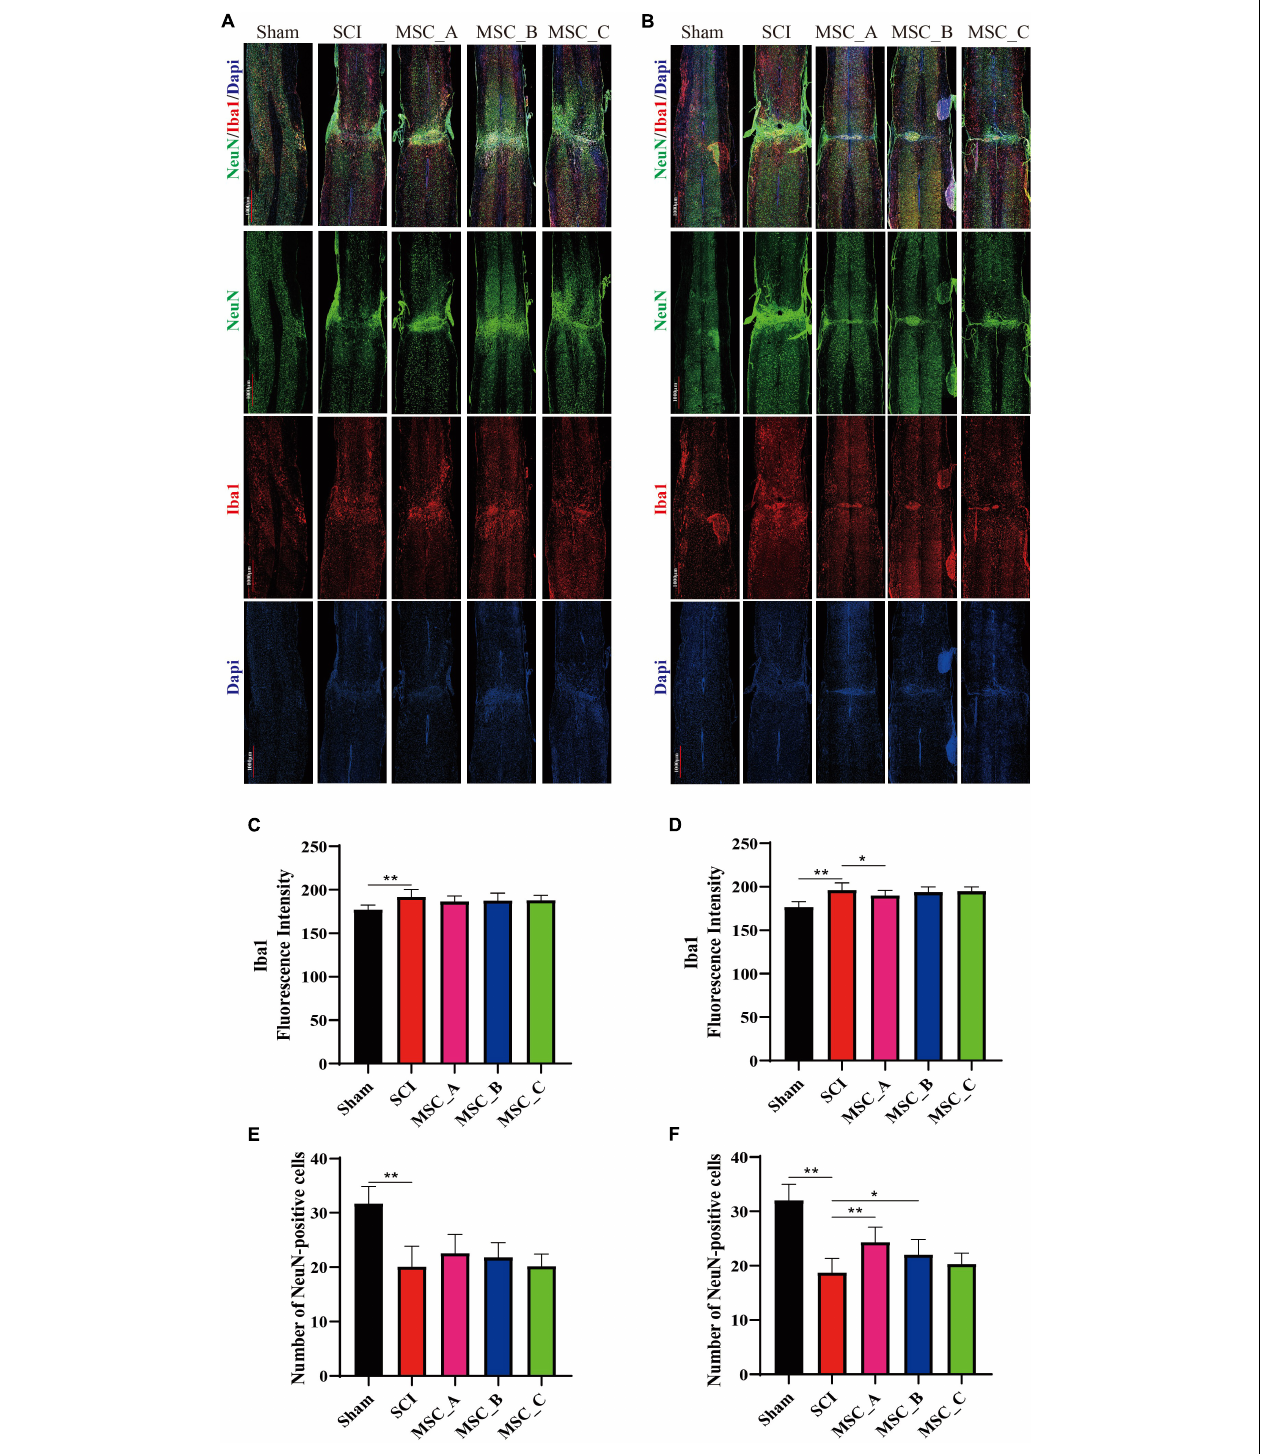
FIGURE 6 | Ionized calcium binding adaptor molecule 1and NeuN immunofluorescence staining at 1 week and 1 month after hUCMSC treatment at dpo 3. Confocal images of immunostaining confirmed the expressions of ionized calcium binding adapter molecule 1 (Iba1, in red), neuron (NeuN, in green), and nucleus (DAPI, in blue) at 1 week (A) and 1 month (B) after hUCMSC transplantation. Quantification of Iba1 fluorescence intensity at 1 week (C) and 1 month (D) after hUCMSC transplantation. Quantification of the NeuN-positive cell number at 1 week (E) and 1 month (F) after hUCMSC transplantation. All data are presented as the mean ± SEM; n = 3; * p < 0.05; ** p < 0.01.